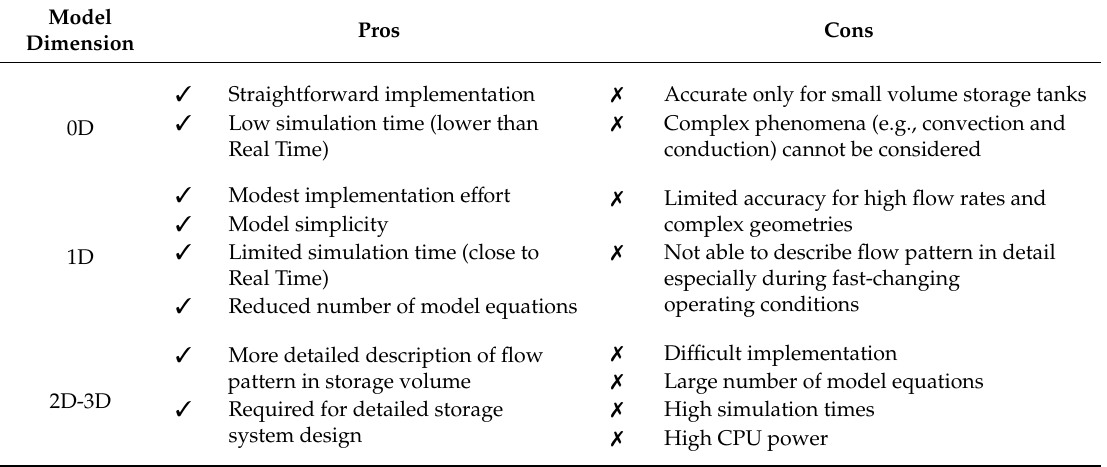
Table 1. Pros and cons for each thermal energy storage (TES) tank modeling